Question: What kind of plot is shown here?
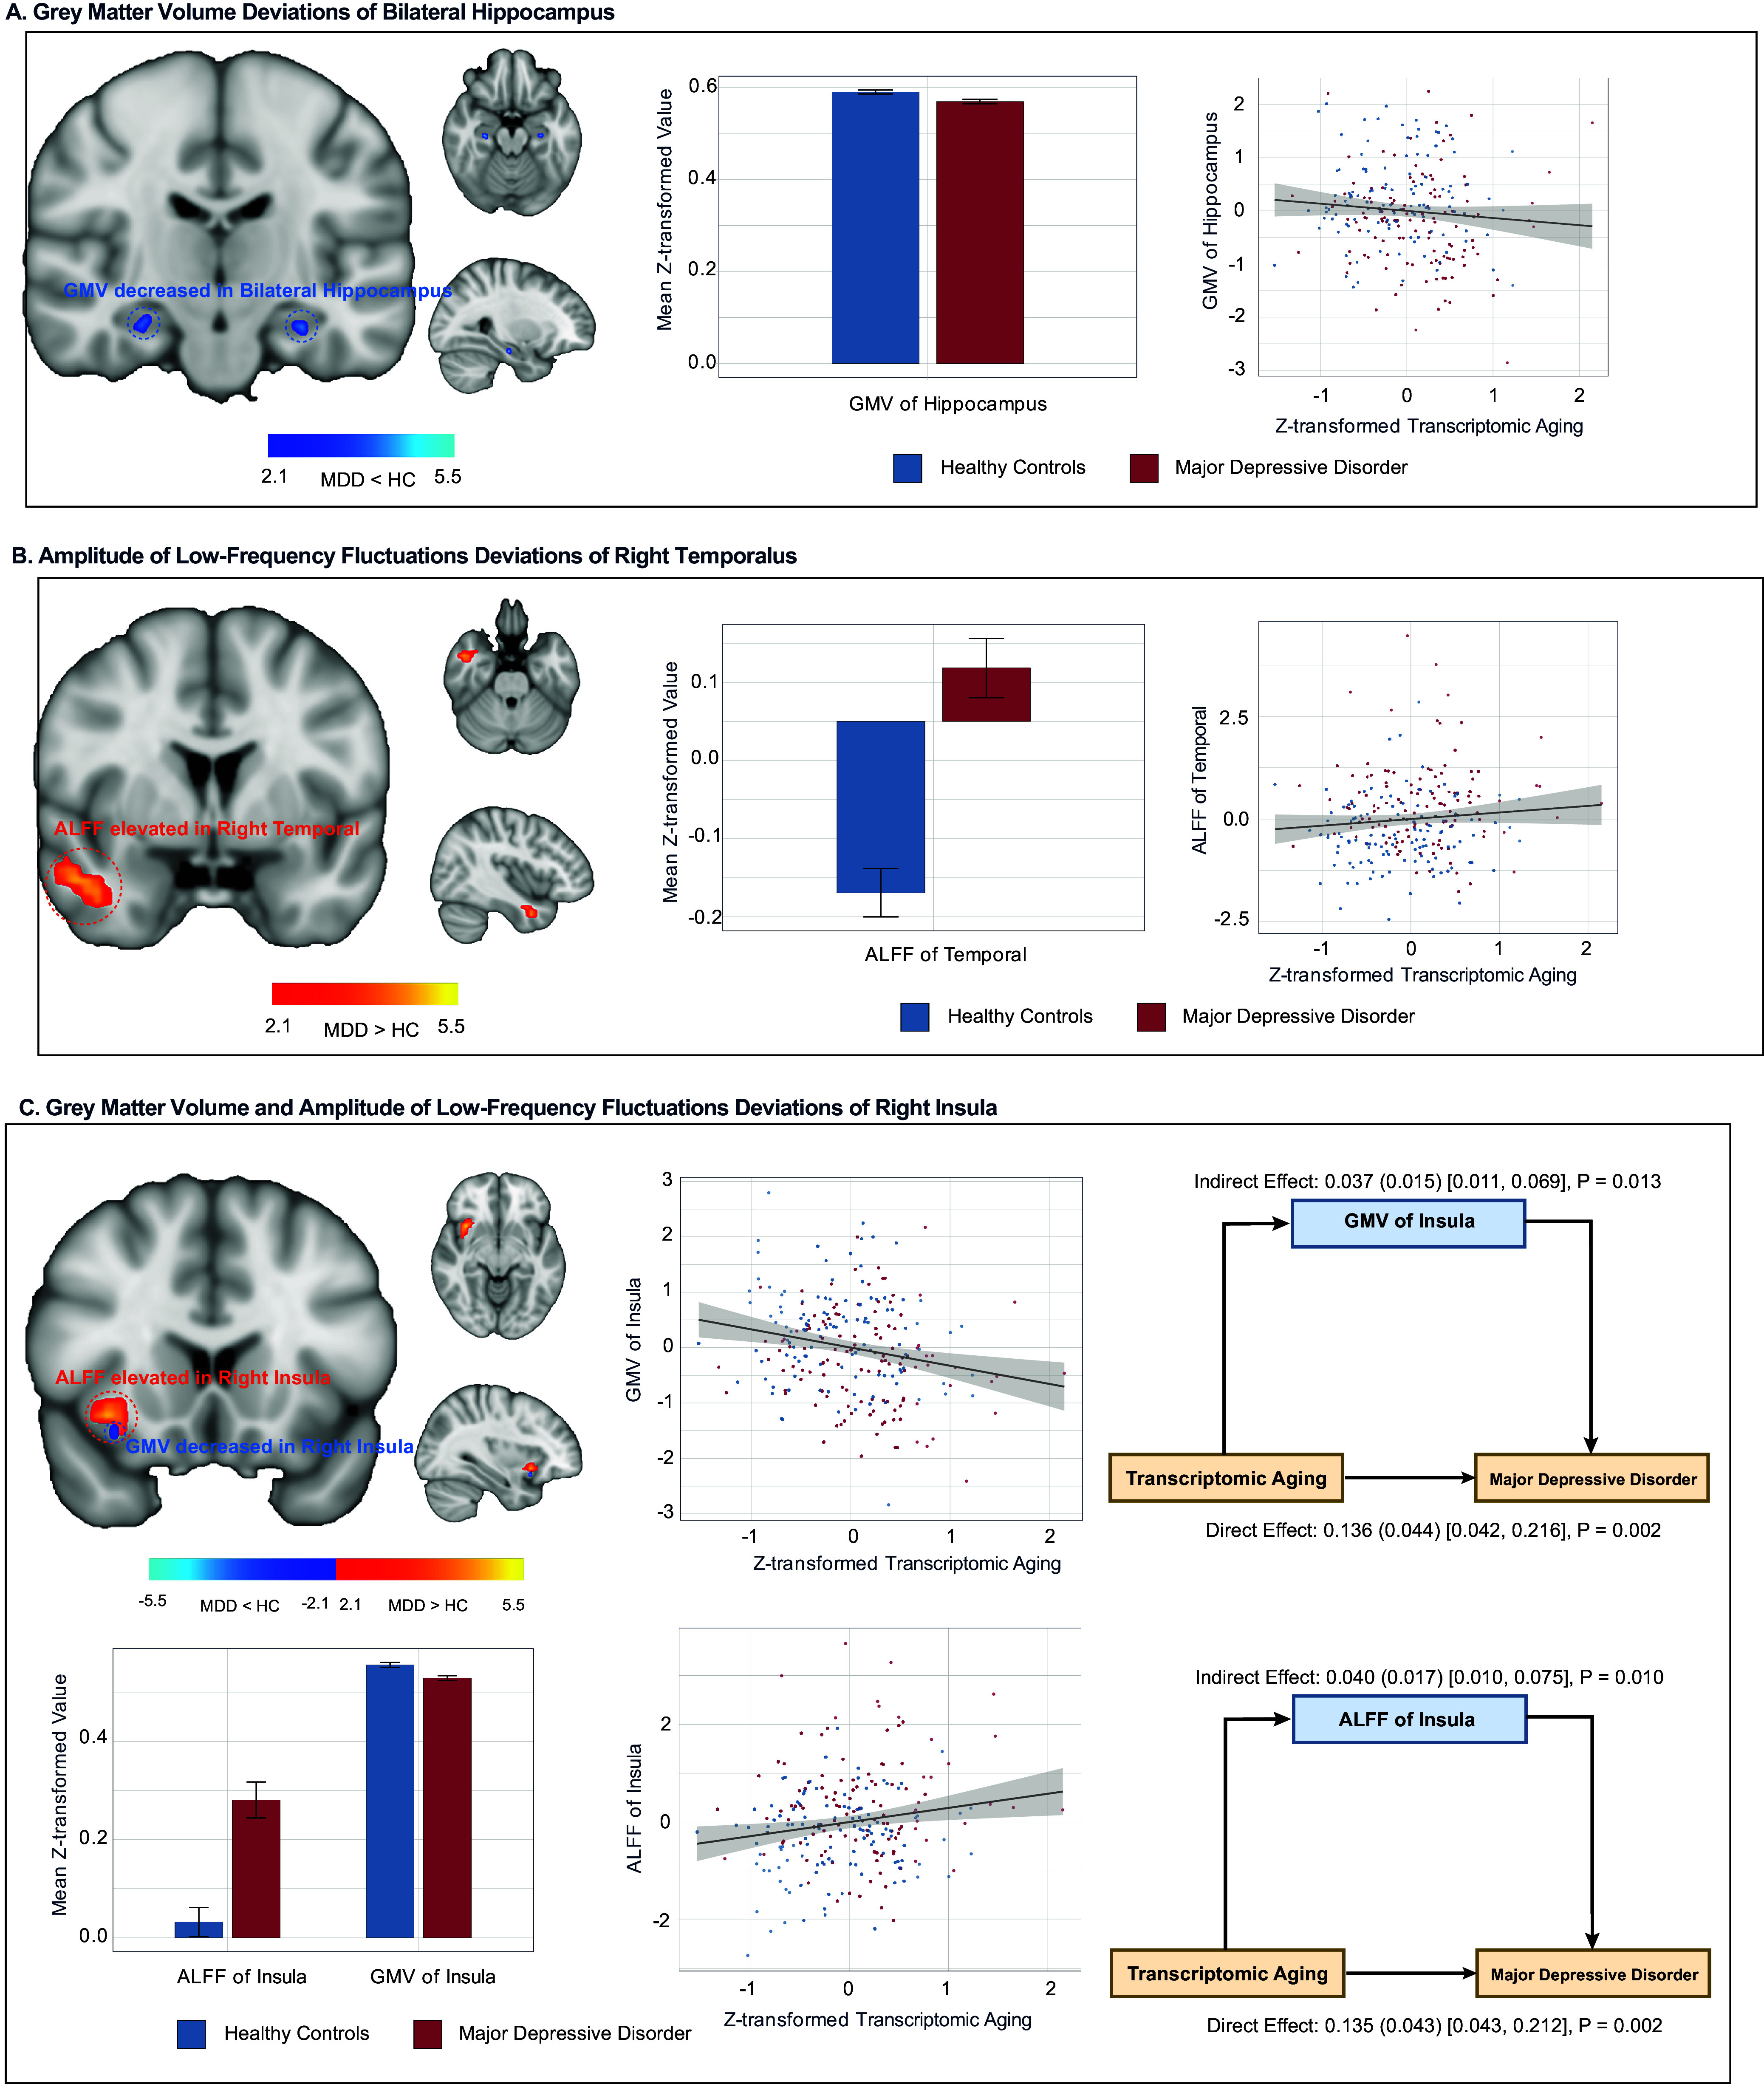
Answer: scatter